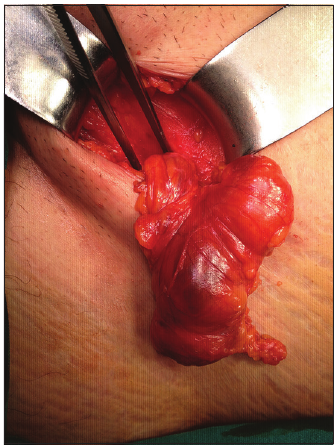
FIGURE 1. Perioperative appearance of a mesenteric cyst pro‑ truded into the femoral canal